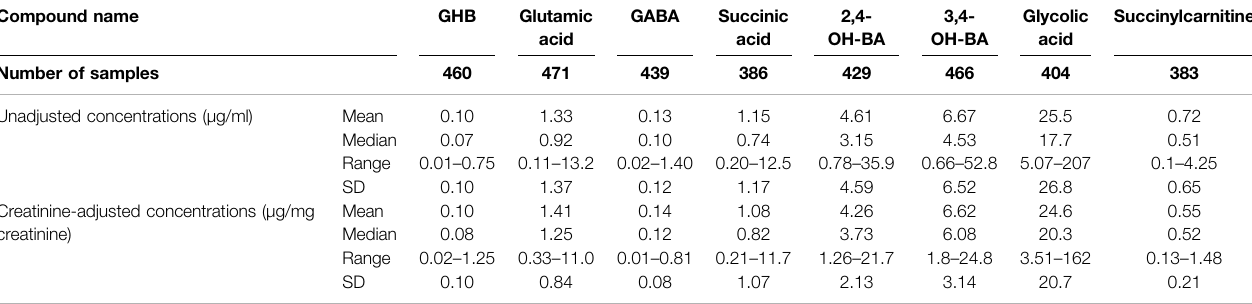
TABLE 2 | Unadjusted and creatinine-adjusted concentrations of endogenous GHB and its biomarker metabolites in urine samples (n = 472) of 206 adult Korean females.